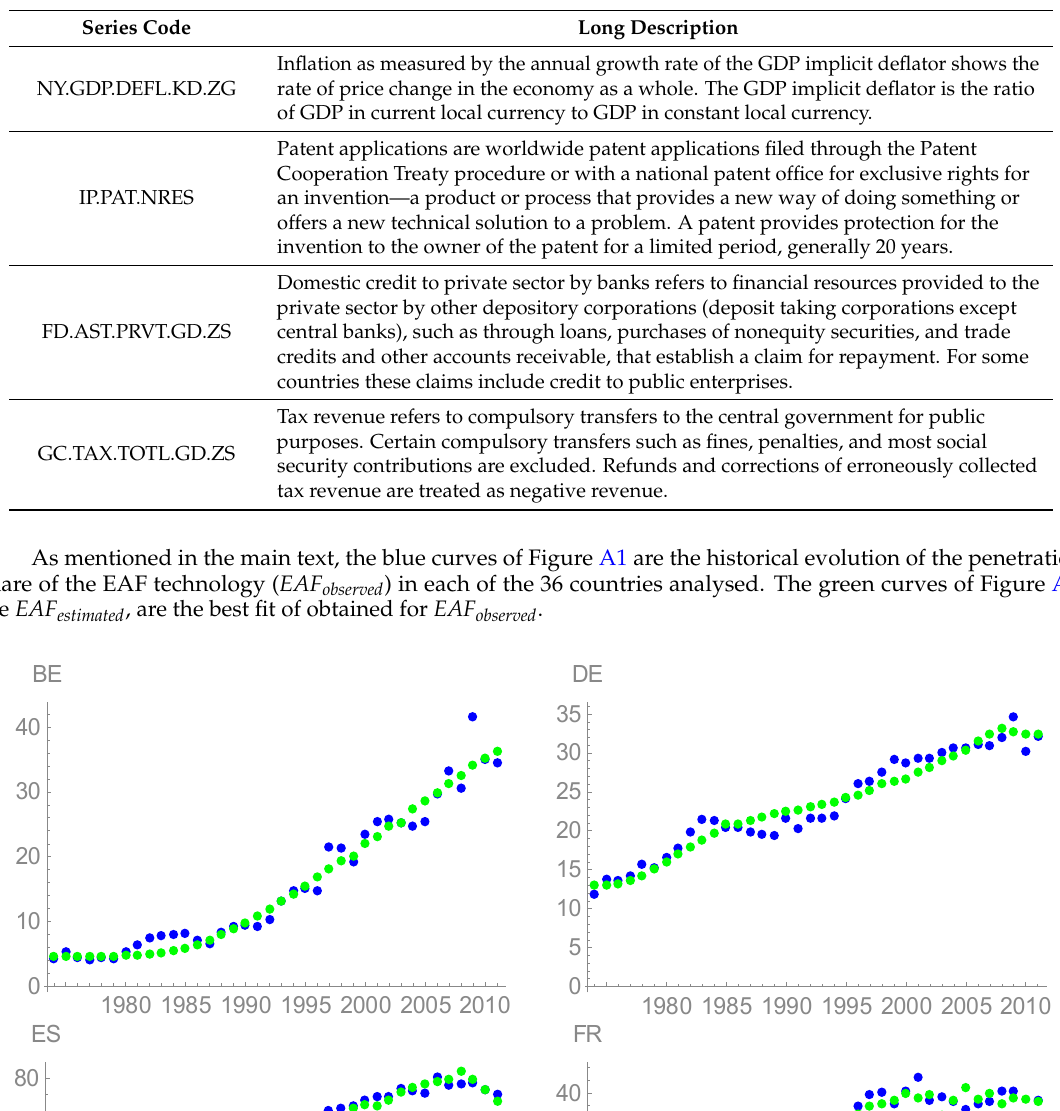
Table A2. Longer description of the terms that for part of the models of Table 4.